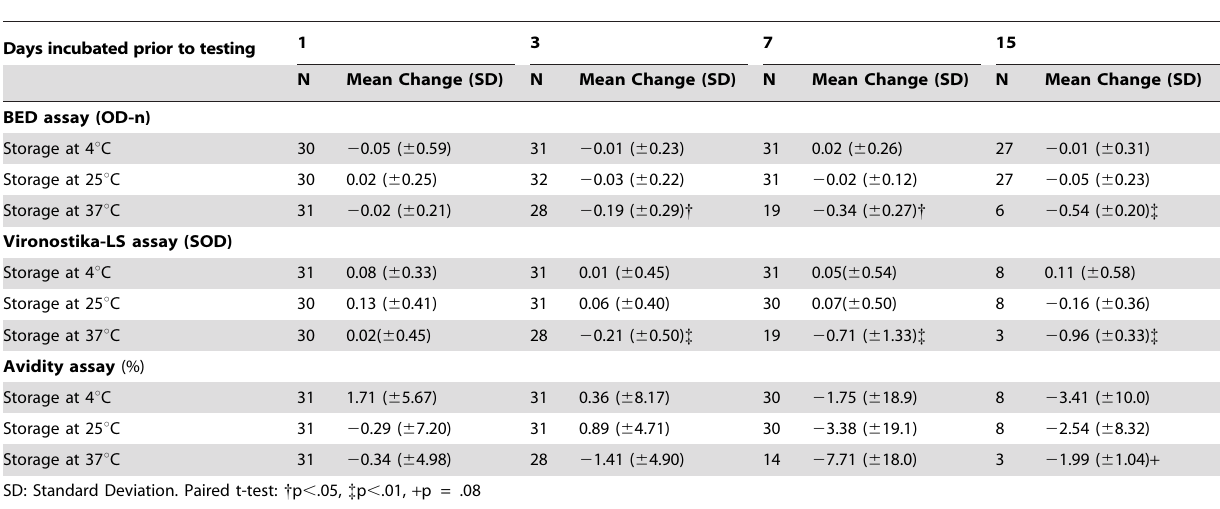
Table 1. Mean Change in Assay Results by Handling